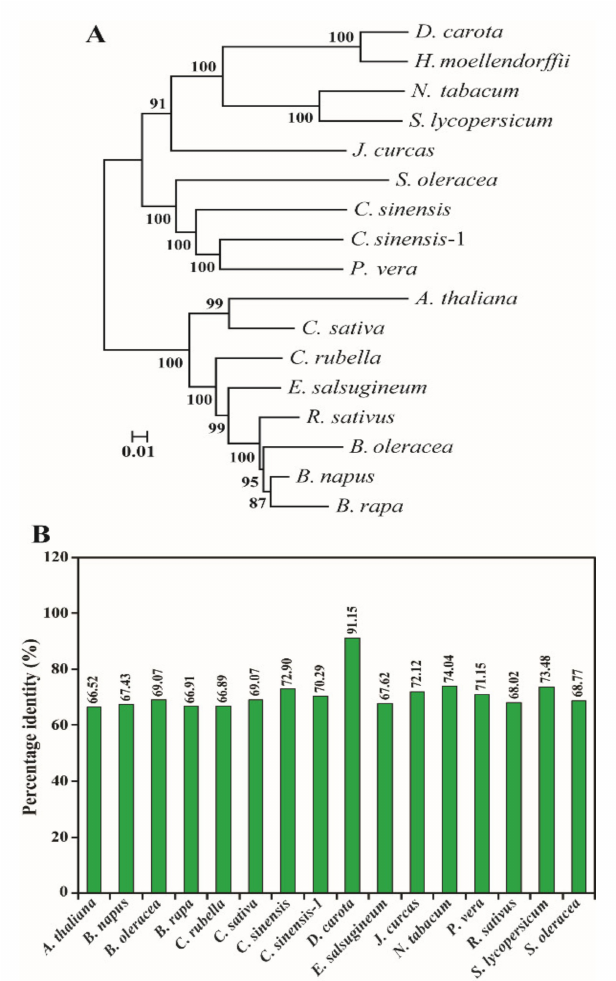
Figure 3. ( A ) Concatenated phylogenetic tree constructed based on the AA sequences of 15 CP, XP, and AP genes of H. moellendorffii . The tree was drawn by using the NJ method with the Poisson- correction distance. The number at each node represents bootstrap values. ( B ) Concatenated per- centage identity (%) analysis of CP, XP, and AP amino acid sequences of H. moellendorffii and other higher plants. The sequences’ accession numbers are provided in Figure S2 and Table S3.